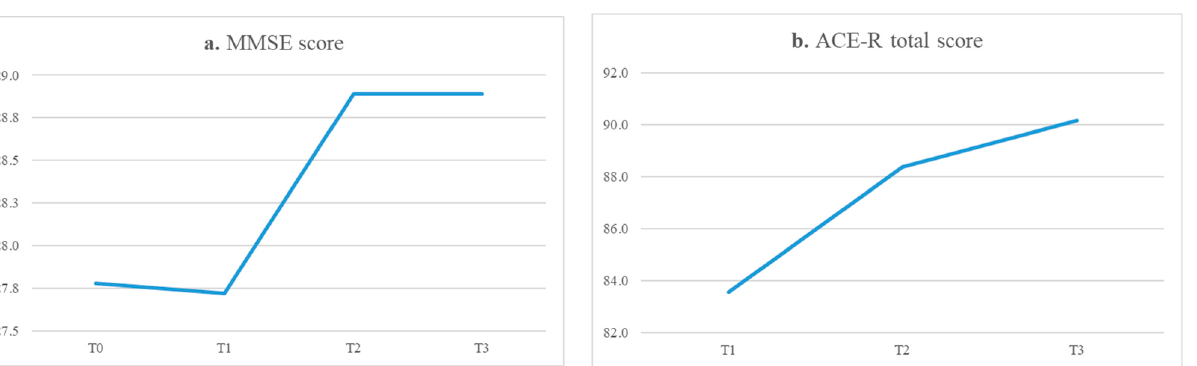
Table 2. Participants’ characteristics at baseline